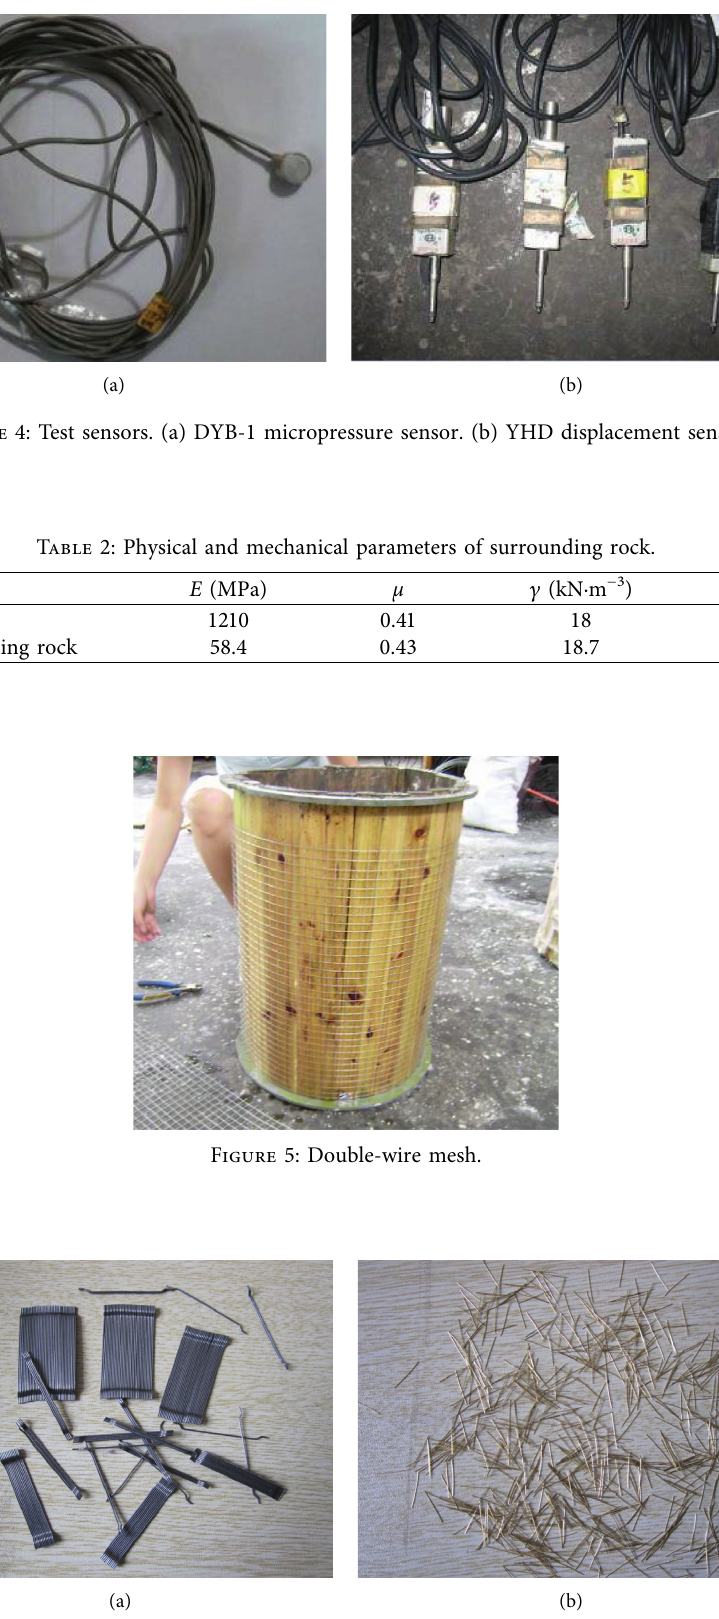
Figure 6: Steel fiber. (a) Engineering steel fiber. (b) Test steel